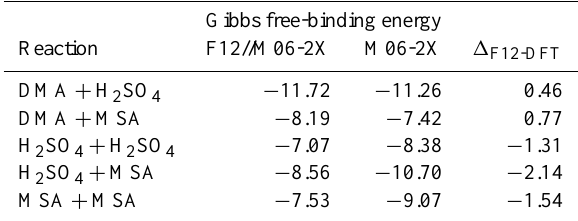
Table 2. Testing the effect of CCSD(T)-F12/VDZ-F12 electronic energy corrections to M06-2X/6-311++G(3df,3pd) Gibbs free en- ergy changes of the indicated reactions. Values in kcalmol − 1